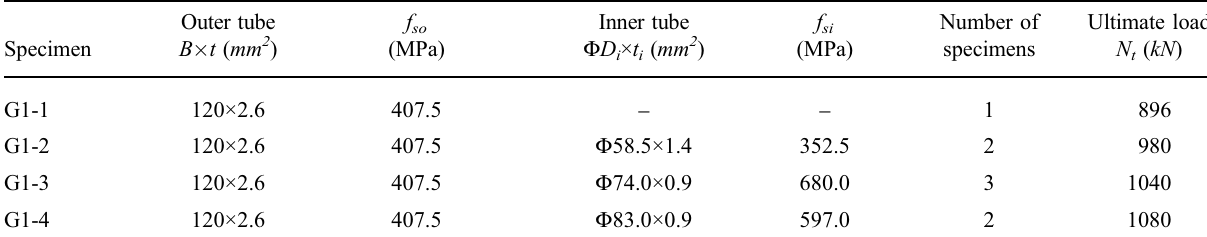
Table 1. Experimental parameters